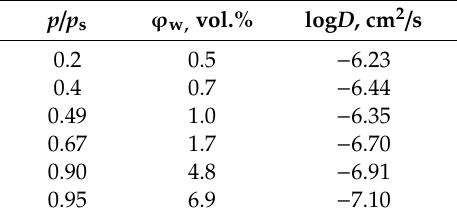
Table 1. E ff ective coe ffi cients of di ff usion D of water vapor by poly(vinyl methyl ether) PVME at 25 ◦ C for di ff erent values of the vapor activity p / p s and volume concentrations of water ϕ w p / p s ϕ w, vol.% log D , cm 2 / s 0.2 0.5 − 6.23 0.4 0.7 − 6.44 0.49